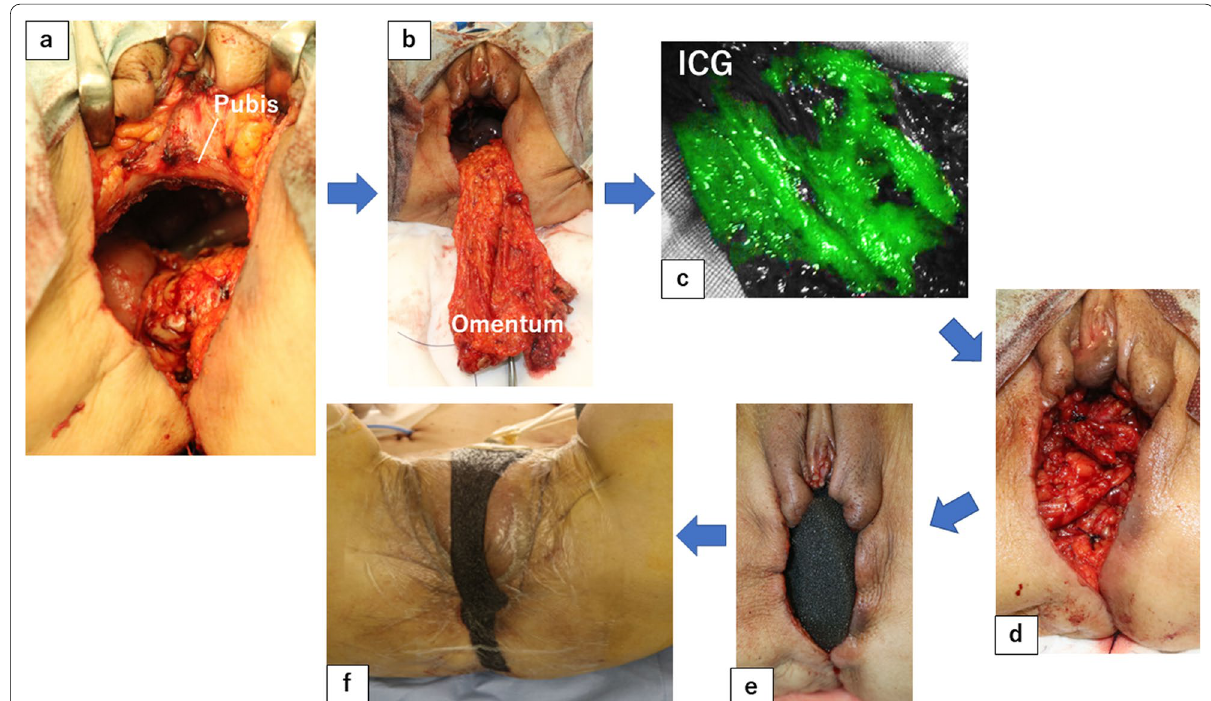
Fig. 3 Methods for creating the omental flap and performing NPWTi-d. After ensuring the omentum was of sufficient volume and had adequate blood flow, it was mobilized to the perineal dead space, where the omental flap was created and NPWTi-d was performed. a Perineal findings after specimen removal. b Omentum after mobilization. c Adequate blood flow in the omental flap confirmed by intravenous injection of indocyanine green dye. d After application of the omental flap. e After application of the foam. f After application of negative pressure wound therapy with instillation and dwelling